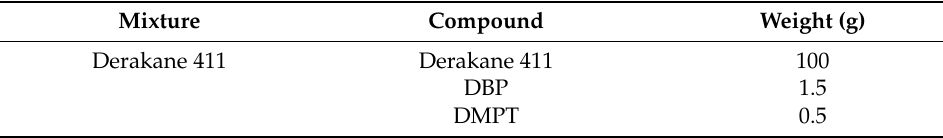
Table A4. The basic recipe of Derakane 411 [9].